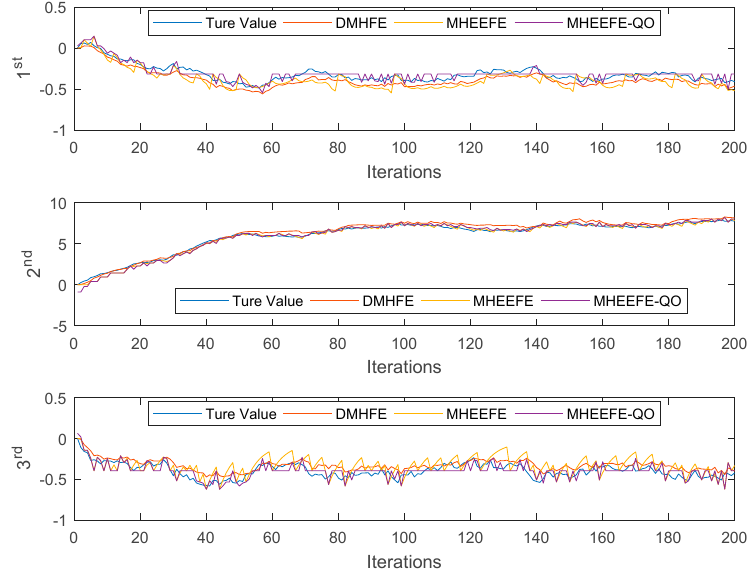
Figure 7. The final estimations for three components with different models.